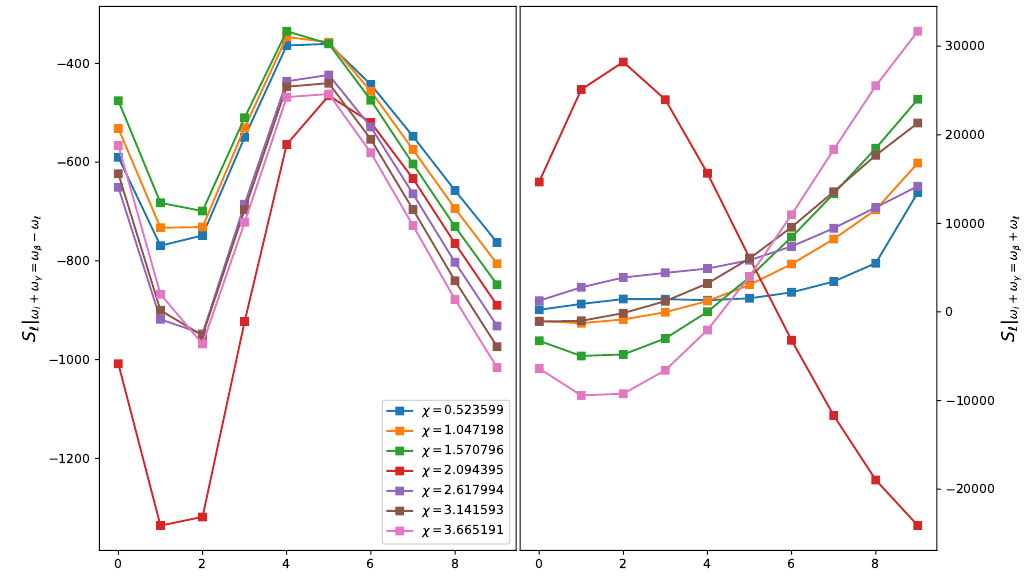
Figure 5. Left: evaluating the source term (3.22) for various values of χ for ‘ < 10 . Right: evaluating the source term (3.25) subject to i + γ ≥ ‘ for the same values of χ and the same range of ‘